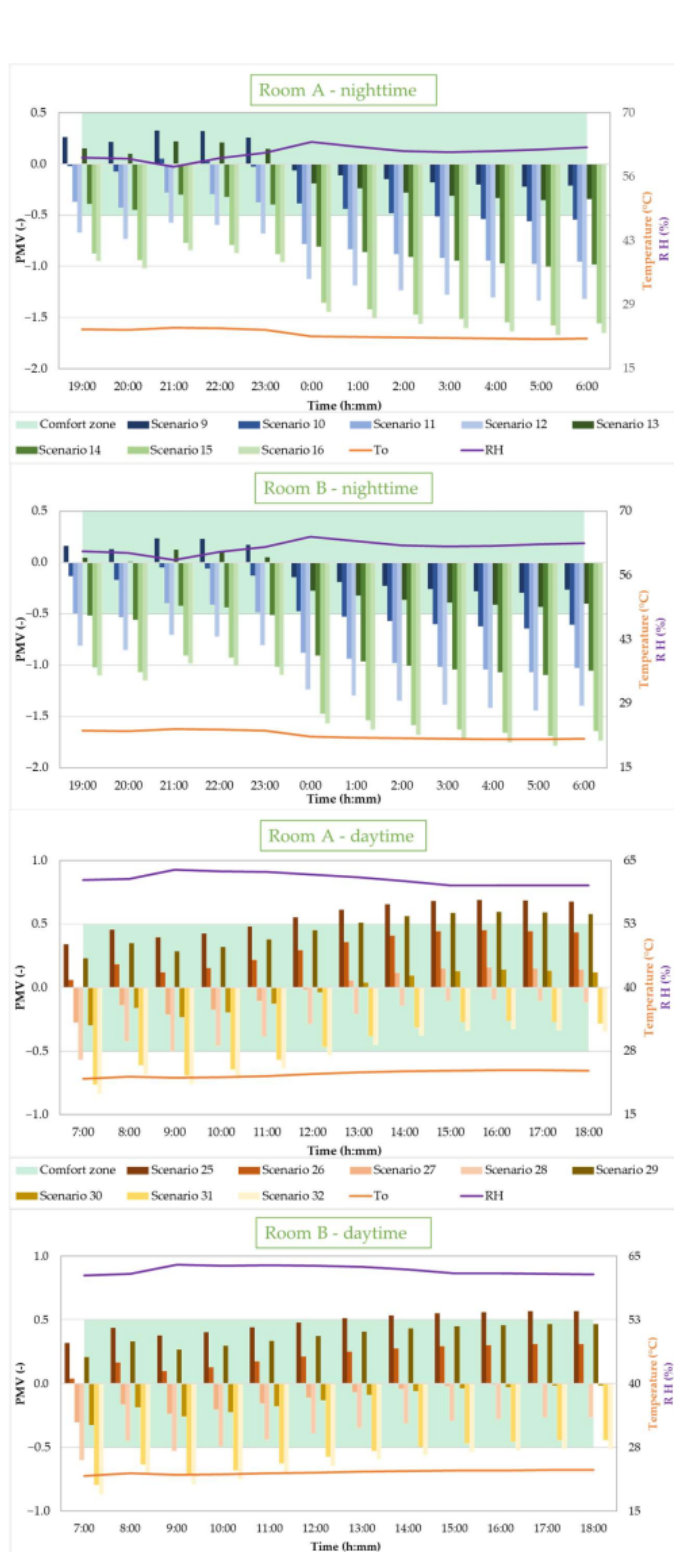
Figure 7. Hourly operative temperature, relative humidity, and PMV in rooms A and B with a bedridden patient: different scenarios in the spring